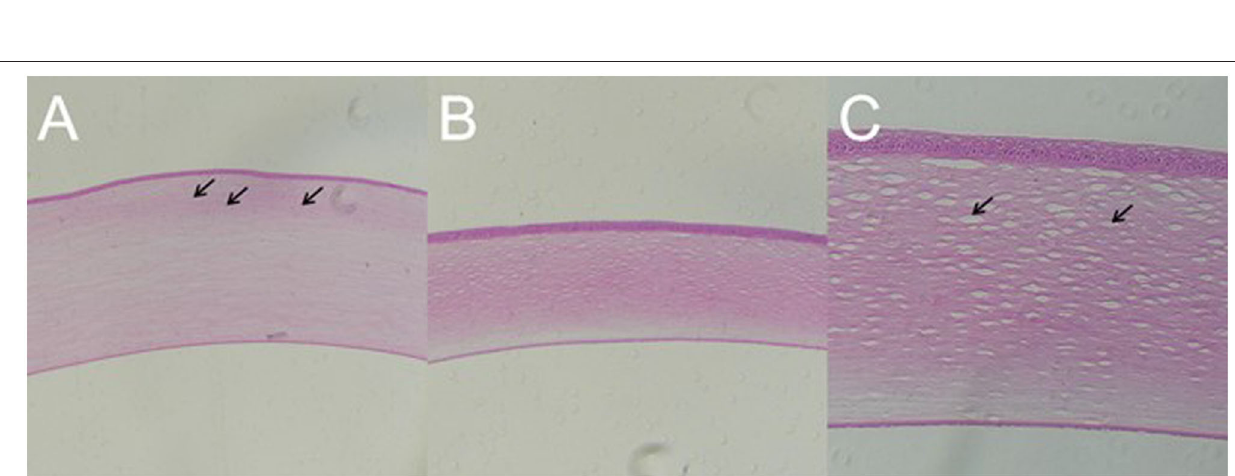
Frontiers in Medicine |